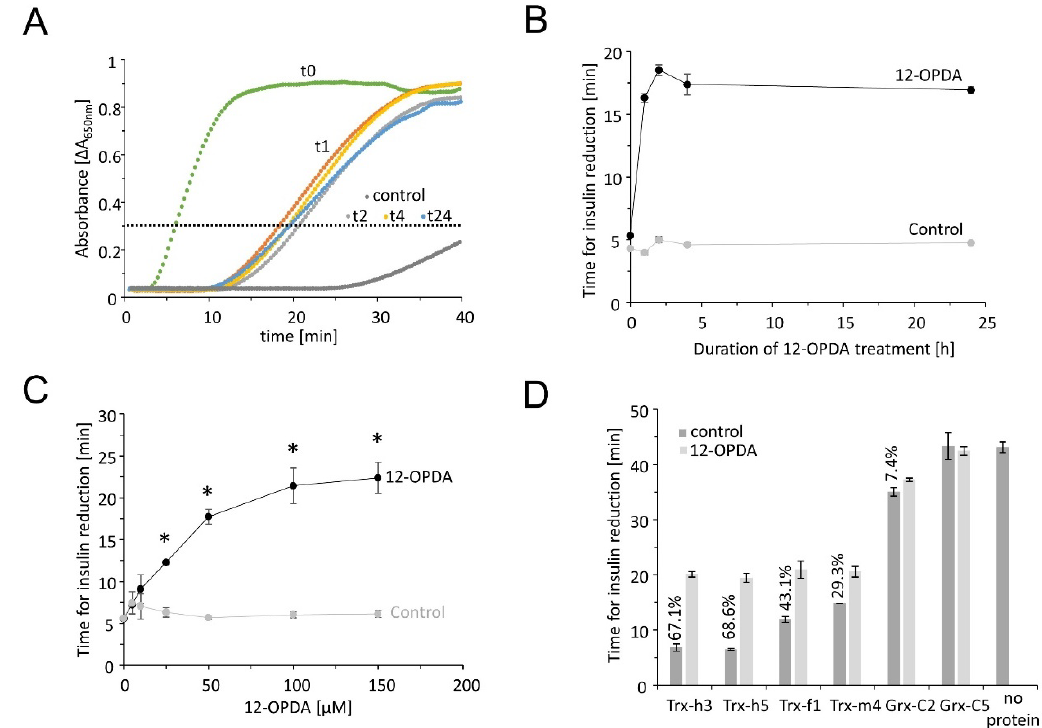
Figure 2. Insulin reduction catalyzed by the redox transmitters TRX-f1, -m4, -h3, -h5 or GRX-C2 with or without 150 µ M OPDA pretreatment. Recombinant TRX-f1, TRX-m4, TRX-h3, TRX-h5 and GRX-C2 were reduced and desalted, and either treated with OPDA or the equivalent amount of ethanol as solvent control. In total, 160 µ M insulin was placed in the well of a 96-well plate and 5 µ M test protein added at t = 0 min. Absorbance increase indicates reduction and precipitation of insulin. ( A ) Exemplary spectroscopic recordings with TRX-h3. The horizontal line indicates the threshold for detailed analysis. Protein was incubated with 12-OPDA for 0 (referred to as t0), 1 (t1), 2 (t2), 4 (t4) or 24 (t24) hours prior to the insulin reduction assay. Additionally, the DTT control is shown in grey. In this case, the absorbance recording remained below the threshold throughout the recorded time span. ( B ) Time-dependent effect of OPDA on reduction activity of TRX-h3. Data are means ± SD of n = 5. Time [min] refers to the time needed to reach the threshold of ∆ A 650 nm = 0.3. ( C ) Concentration-dependent effect of OPDA treatment for 1 h on activity of TRX-h3. Data are means ± SD of n ≥ 4. Significance of difference was determined using t -test ( p < 0.001) and is marked with *. ( D ) Comparison of activity of the redox transmitters and inhibitory effect of OPDA [%]. Data are means ± SD of n = 5.